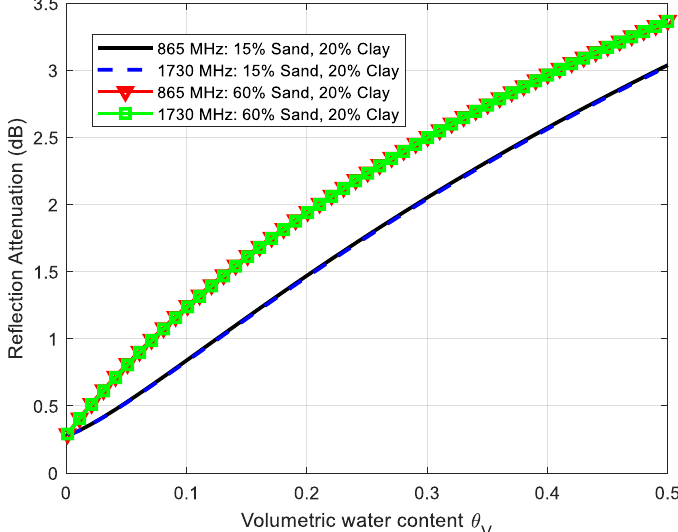
Figure 12. Simulated reflection attenuation in dB calculated from Equation (1) as a function of the volumetric water content of the soil at 865 MHz and 1730 MHz for two soil cases.